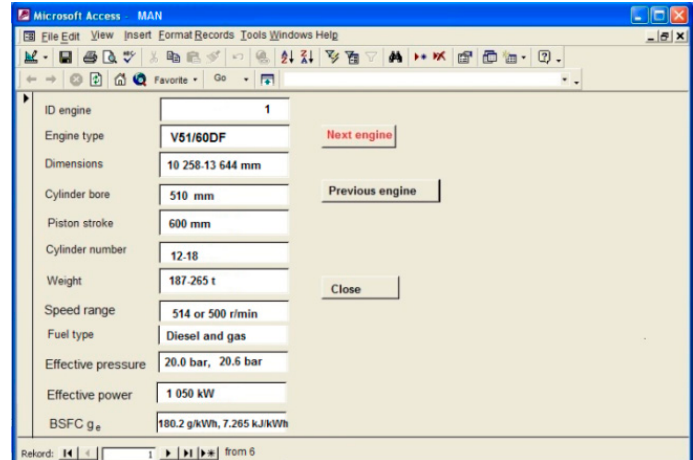
Figure 7. View of the content of the data form with selected parameters exemplary four stroke engine of the MAN Energy Solution company.